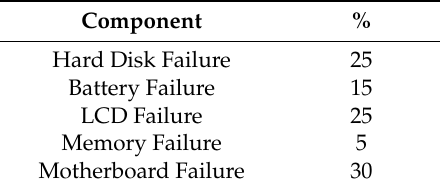
Table A6. Subassembly and component failure